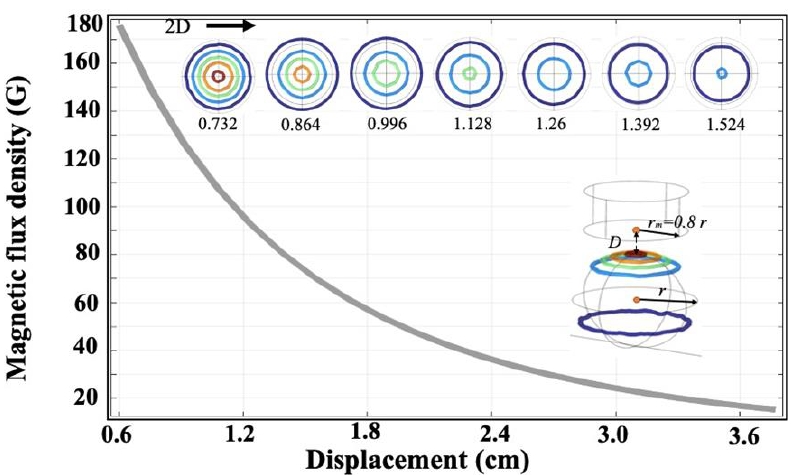
Figure 7. Magnetic flux density versus the electromagnet’s displacement from the ocular surface.